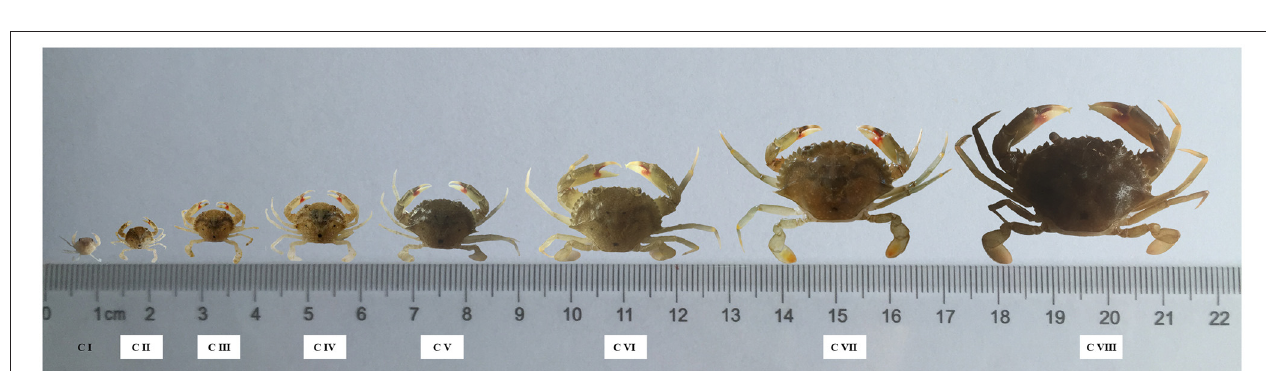
FIGURE 1 | Measurement indexes of the Scylla paramamosain crablet. CL, carapace length; CW, carapace width; AW1, first abdomen width; AW2, second abdomen width; AW3, third abdomen width; AW4, fourth abdomen width; AW5, fifth abdomen width.